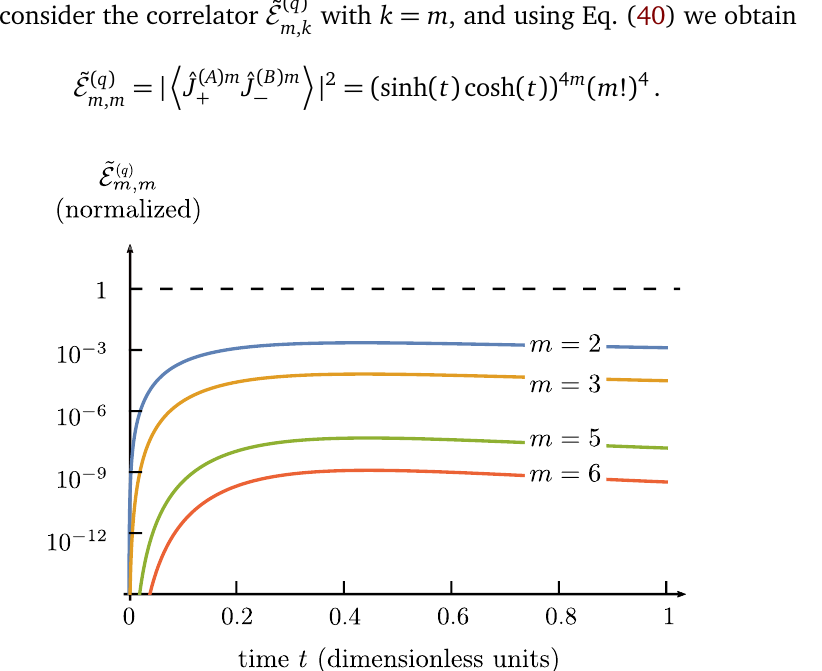
( q ) Figure 4: The correlator ˜ E from Eq. (41) for m = 2,3,5,6 (top to bottom curve) m , m as a function of time and normalized to the local realistic bound (31). The Figure shows that the values of all the correlators lie well below the Bell